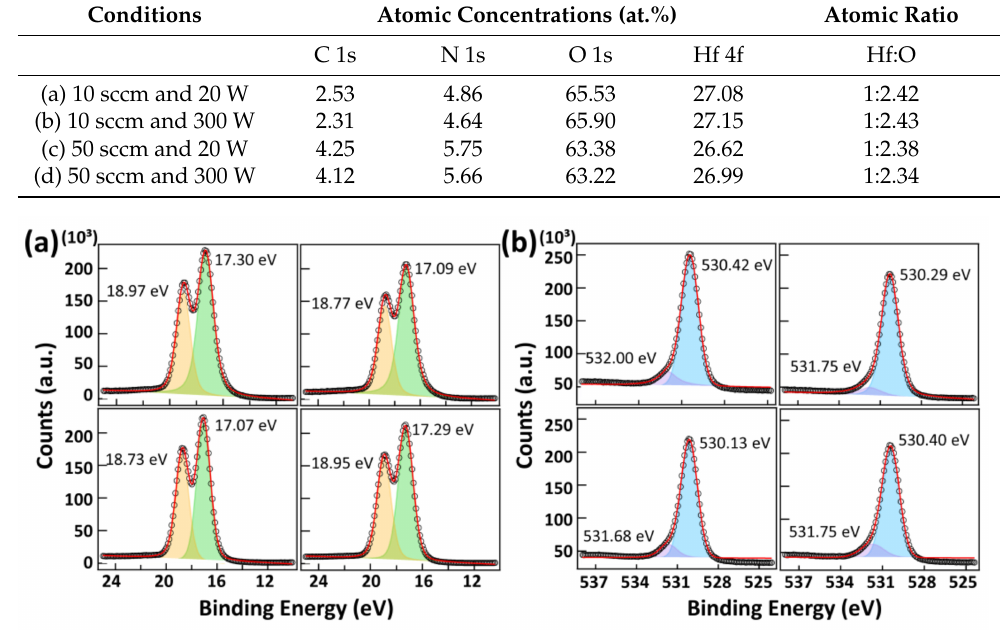
Figure 3. HRXPS spectra of the HfO 2 films deposited at different O 2 flow rates and O 2 plasma power: ( a ) the Hf 4f XPS spectra, ( b ) the O 1s XPS spectra of the as-deposited HfO 2 films. (Top panel: O 2 flow rate 10 sccm, lower panel: O 2 flow rate 50 sccm, left side panel: O 2 plasma power 20 W, right side panel: O 2 plasma power 300